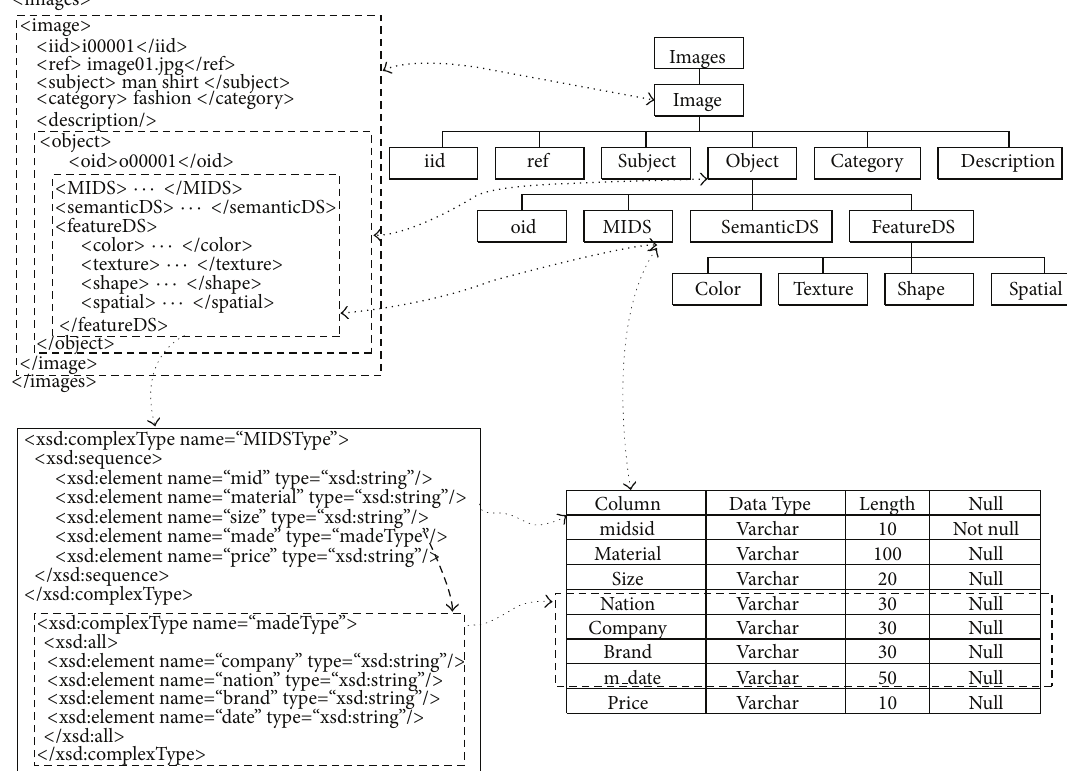
Figure 10: Mapping XML-Schema to relational tables.